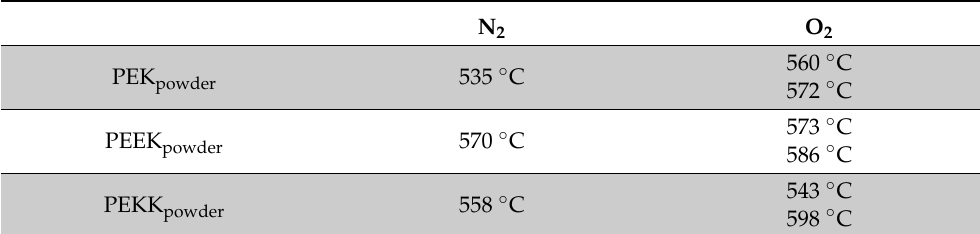
Table 3. Decomposition onset temperatures of PEK, PEEK and PEKK in N 2 and O 2